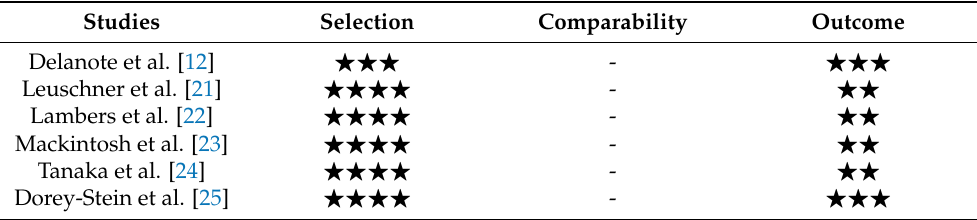
Table 2. Risk of bias assessment for cohort study using Newcastle–Ottawa Scale.